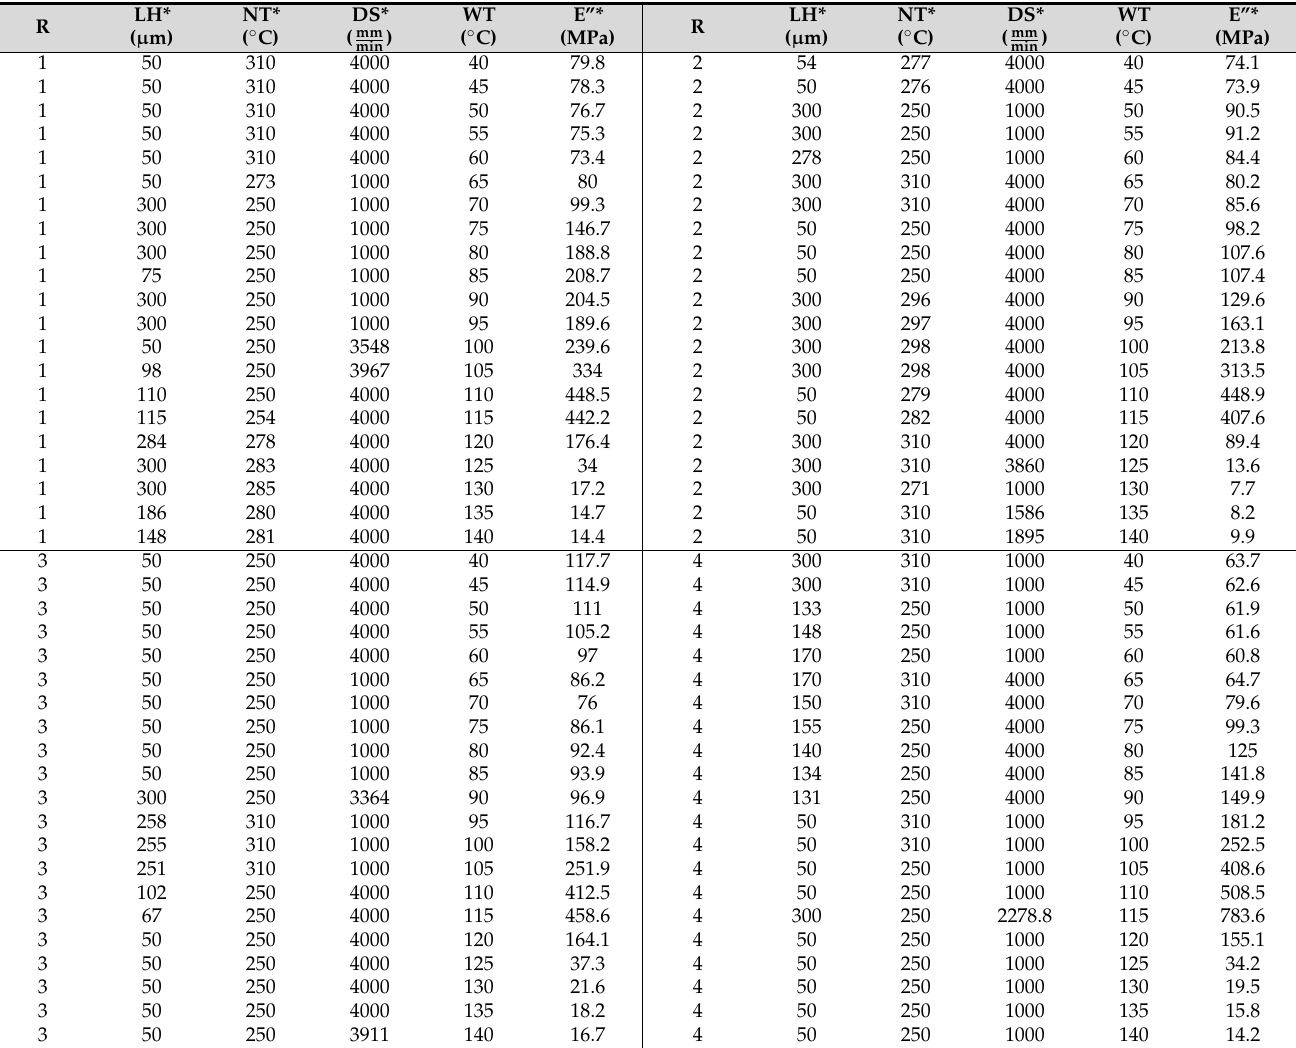
Table A2. The optimum values (look-up table) of the process parameters using PSO on E” at each raster orientation level and under each working